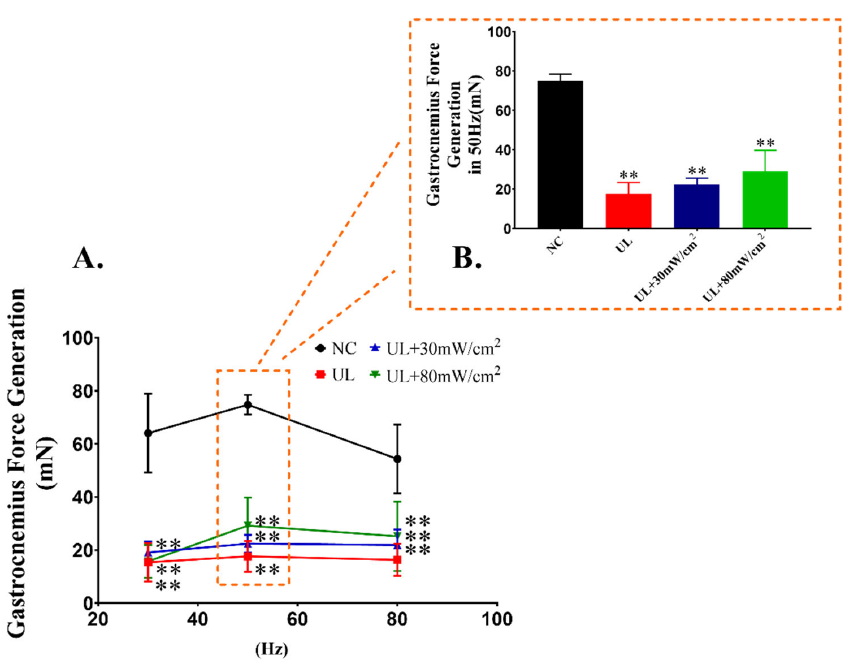
Figure 3. ( A ) The gastrocnemius force generation stimulated at 30, 50 and 80 Hz. ( B ) The gastrocnemius force generation stimulated at 50 Hz. The data were expressed as mean ± SD ( n = 8 in each group), ** p < 0.01 vs. NC group.